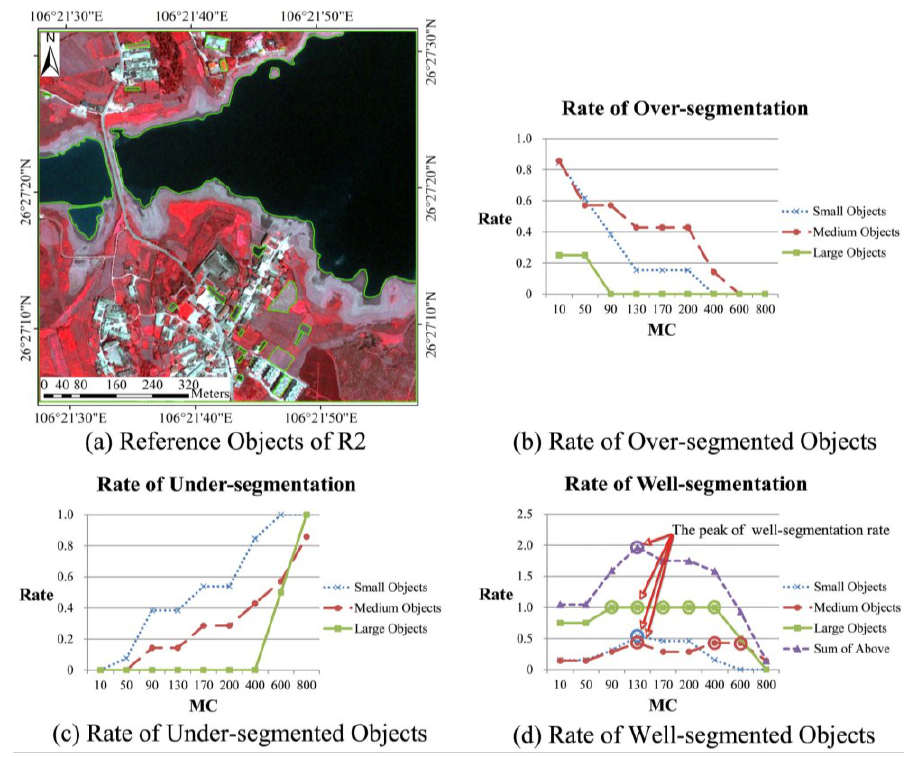
Figure 11. Quantitative assessment results by different MC values in R2. ( a ) is the reference objects of R2, including 13 small objects (100–399 pixels), 7 medium size objects (400–1999 pixels) and 4 large objects (more than 2000 pixels); ( b – d ) display the rates of over-segmented, under-segmented and well-segmented,